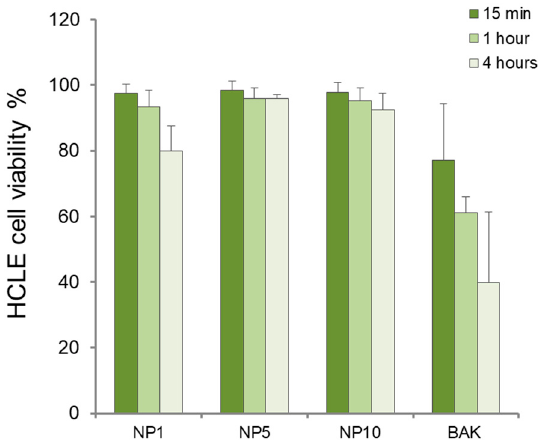
Figure 5. Human corneal–limbal epithelial (HCLE) cell viability in percentage (coefficient of variation, c.v.) for HEMA/Bayfit-MA copolymer nanoparticles NP1, NP5, and NP10. Benzalkonium chloride 0.005% (BAK) was used as positive control.